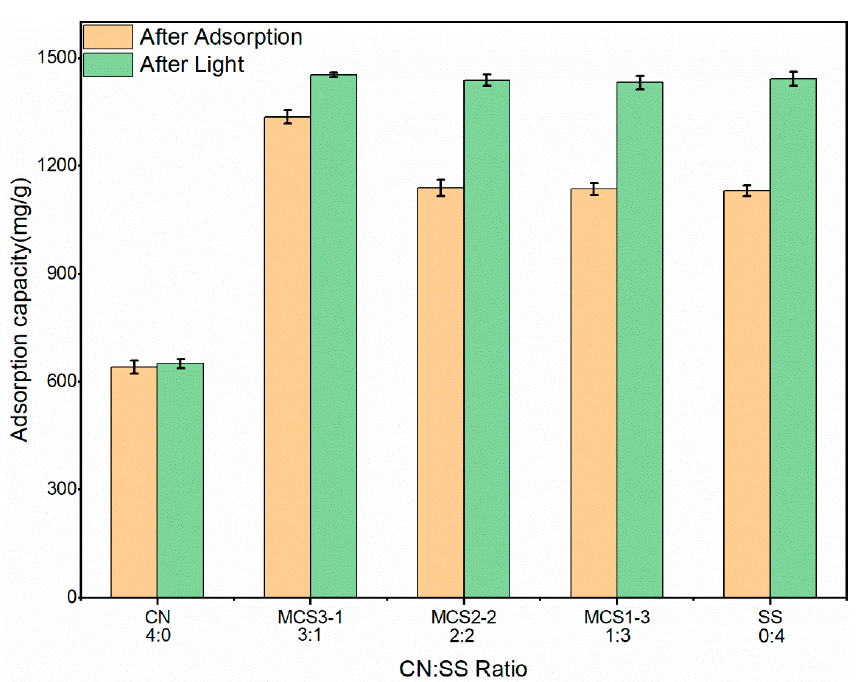
Figure 12. The influence of the adsorbent CN:SS ratio.